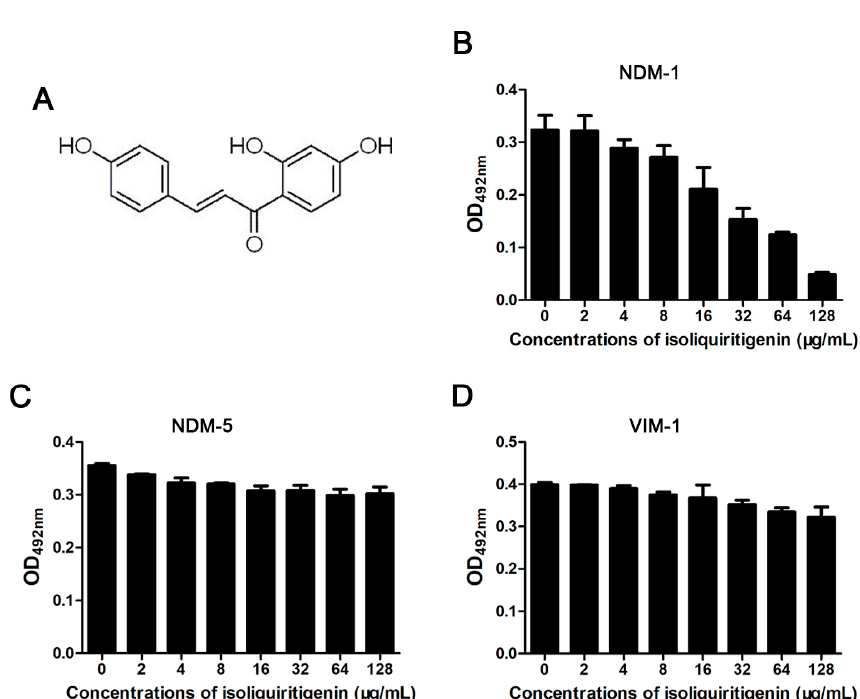
Figure 1. The e ff ect of isoliquiritin on class B β -lactamase activity. The chemical structure of isoliquiritin ( A ). Enzyme inhibition assays were used to detect the activities of New Delhi metallo- β -lactamase-1 (NDM-1); ( B ), New Delhi metallo- β -lactamase-1 mutants (NDM-5); ( C ) and Verona integron-encoded metallo- β -lactamase -1 (VIM-1) ( D ) in the presence of various concentrations of i soliquiritin .